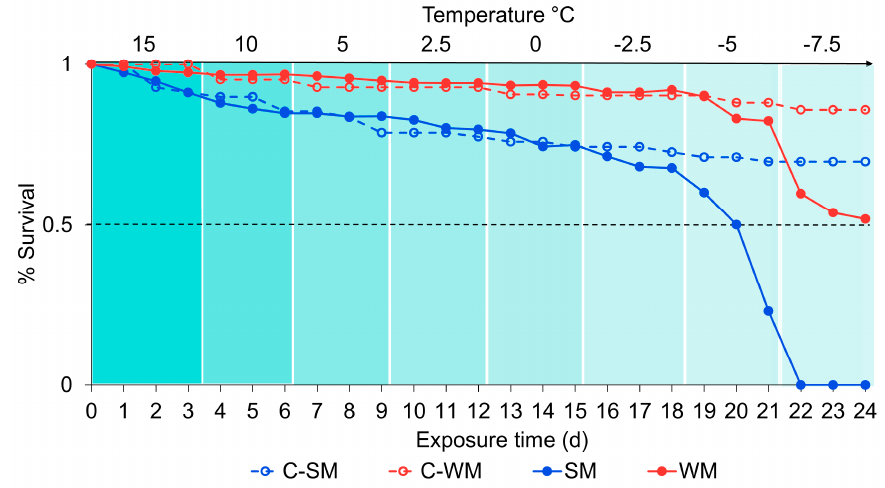
Figure 6. The effect of gradual cooling on mean survivorship in adult SM and WM D. suzukii . Survivorship was observed (y-axis) as the temperature (x-axis TOP) decreased over time (x-axis BOTTOM) in 3 days intervals. Color bands indicate differences in temperature, with lighter bands being cooler than darker bands. The solid dots and lines indicate percent survival per replicate among flies in the gradual cooling treatments (SM and WM). Open dots and dashed lines indicate flies in the control treatments (C-SM and C-WM) which were kept at 15 °C for the duration of the study. Temperature was also a significant factor ( χ 2 = 312, df = 1, p < 0.001). Survival remained high above − 5 °C. After 72 h at − 5 °C, the proportion of surviving SM flies declined from approximately 68% to 23%. In contrast, there was only a 7% decline in survival among WM flies during this period. At − 7.5 °C no SM flies survived 24 h exposure. However, after 72 h exposure to − 7.5 °C, approximately 52% WM flies survived. Of the surviving WM flies at the end of the experiment, 33% were male and 67% were female.